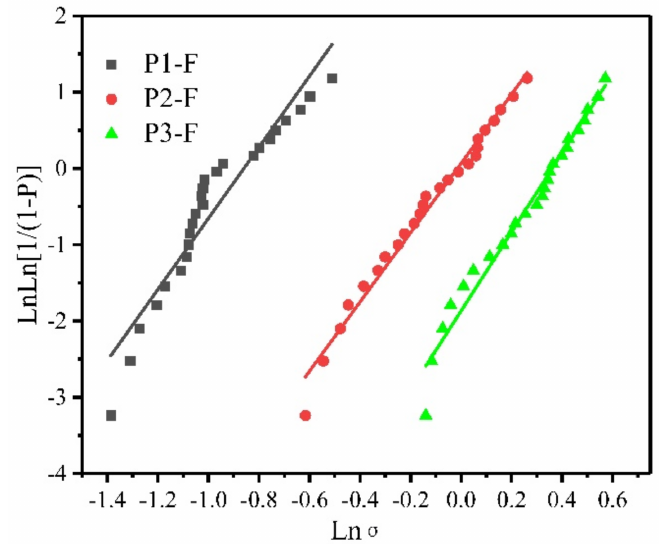
Figure 8. Weibull plot of failure strengths of three composite fiber diameters.